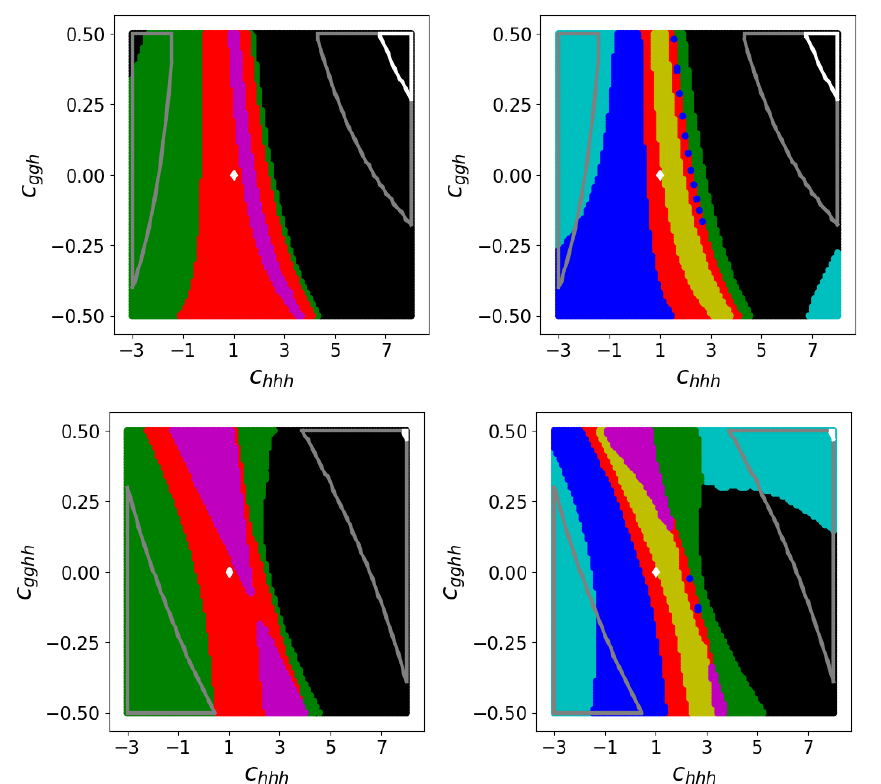
Figure 14 . Shape types produced by variations of c hhh versus c ggh (top) and c gghh (bottom). Left: 4 clusters, right: 7 clusters. The areas outside the silver and white curves are regions where the total cross section exceeds 6 : 9 (cid:2) (cid:27) SM and 22 : 2 (cid:2) (cid:27) SM , respectively. These values are motivated by p the current ATLAS/CMS limits at s = 13 TeV [1, 2]. The red areas denote SM-like shapes. The full colour code is given in table 1.